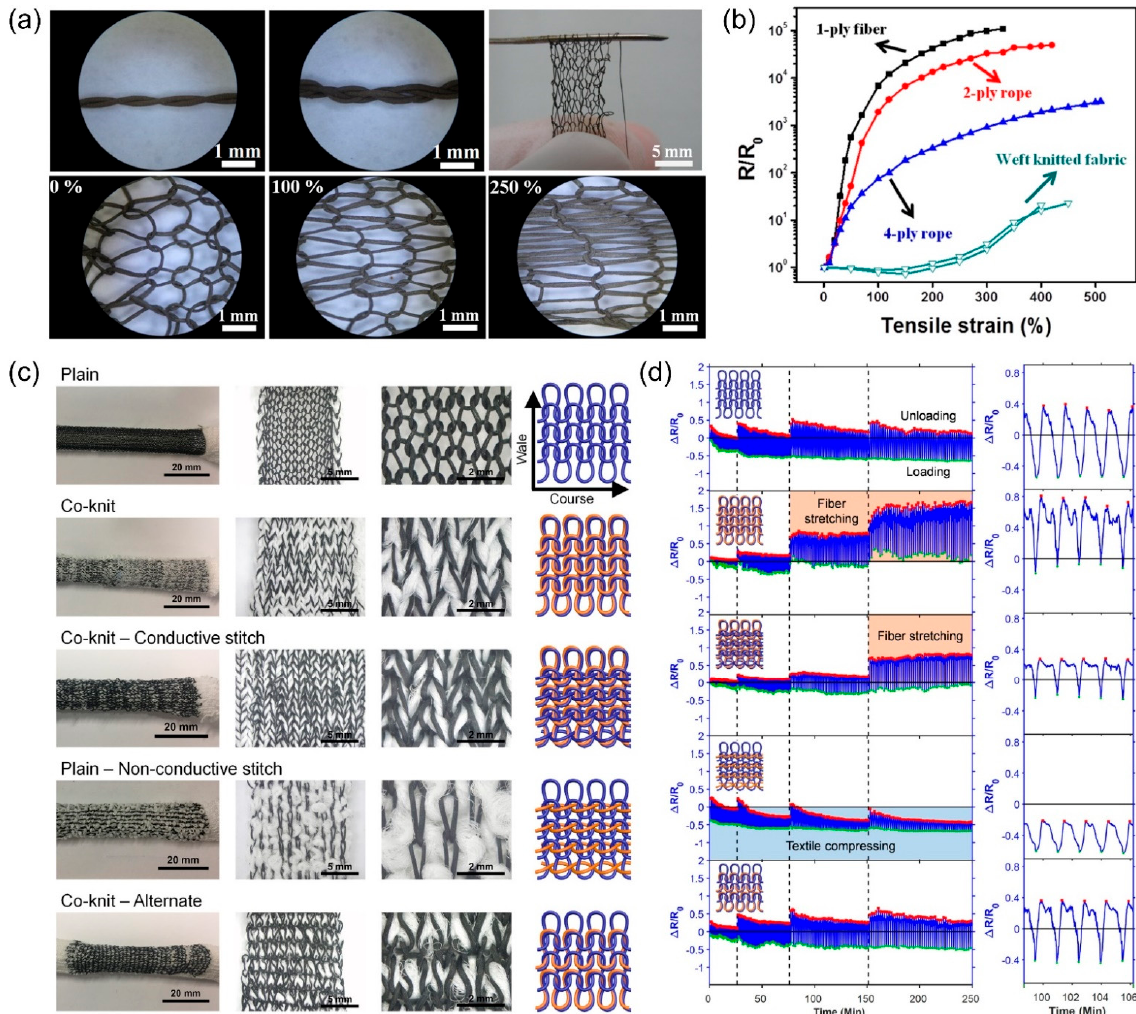
Figure 12. ( a ) Optical images of the two − ply, two − ply rope, and kni tt ed fabric before and after stretching; ( b ) the plot of normalized resistance vs. tensile strain; Reprinted with permission from Ref. [99] . 2014, American Chemical Society. ( c ) photographs, optical images, schematics; and ( d ) strain sensing behaviors of different knitted structures based on PU/PEDOT:PSS filaments. Reprinted with permission from Ref. [100]. 2018, Elsevier.